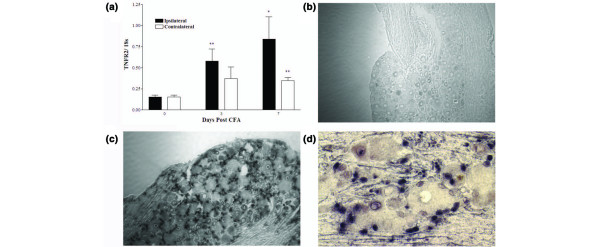
TNFR2 mRNA is increased following inflammation in the dorsal root ganglion (DRG). (a) Real-time RT-PCR showed an increase in mRNA of tumour necrosis factor receptor type 2 (TNFR2) (expressed as the ratio of TNFR2 mRNA to 18S mRNA) in the DRG ipsilateral to inflammation (n = 4), reaching five times its original level by 7 days. Contralateral TNFR2 levels increased significantly 7 days after inflammation. (b) In situ mRNA hybridisation in the naive DRG detected no TNFR2 mRNA. (c) In situ hybridisation detected TNFR2 mRNA in small cells of the DRG surrounding neuronal somata in the ipsilateral DRG 7 days after inflammation. (d) High-power magnification of TNFR2-labelled cells in the DRG, showing a perisomal distribution. *P < 0.05, **P < 0.01. CFA, complete Freund's adjuvant.